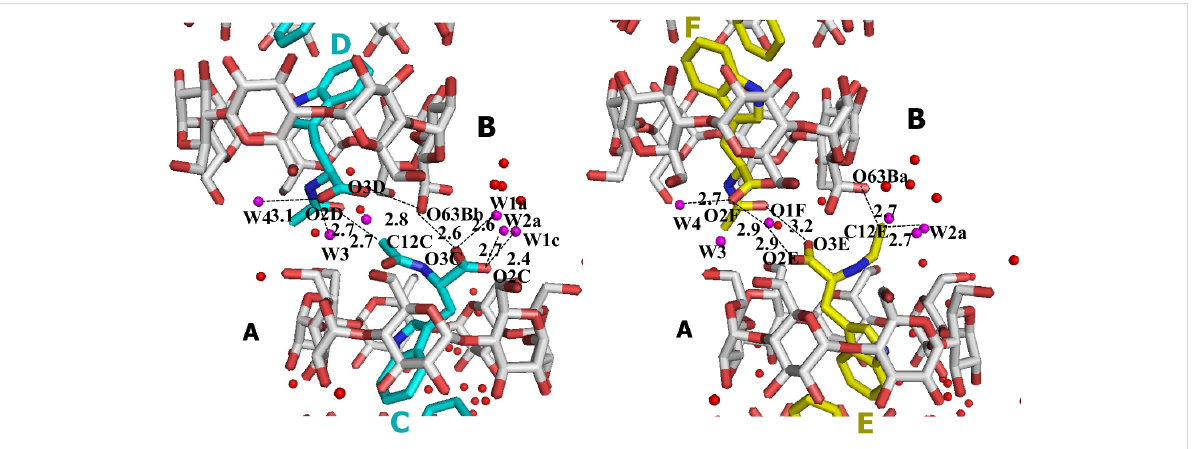
Figure 3: β -CD–L-NAcTrp complex at the interface between two β -CD dimers along the a -axis (major orientation guest molecules C , D in cyan and minor E , F in yellow). Note that the major guests C , D interact (a) directly by O1 D and C12 C through non-conventional H-bonding and (b) indirectly by mutual H-bonding of O3 C and O3 D with the only inward pointing hydroxy Ο 63 B b. Moreover, they are stabilized by the H-bonds of carboxylic oxygen atoms with the structural water molecules OW2a, OW3 and OW4, which interact also with hydroxy groups of the neighbor β -CD hosts. In contrast, the minor guests E and F interact weakly via the carboxylic O3 E and acetyl O1 F atoms and indirectly via a low occupancy water molecule W5, whereas the acetylamino methyl group is exposed to the water molecules in the exterior of the broken channel.